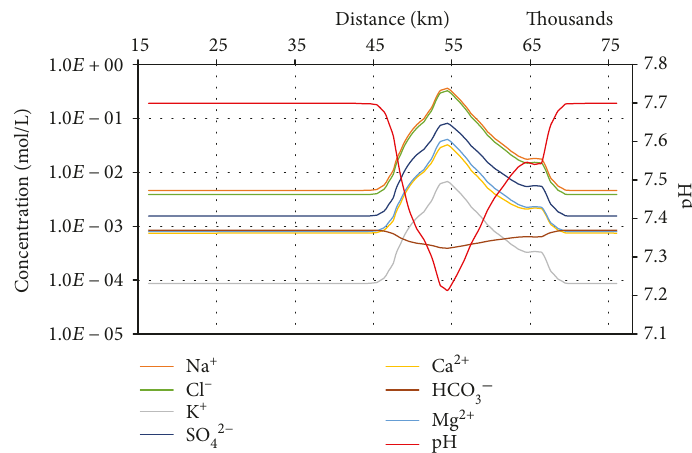
Figure 10: Concentrations (units in moles/L, except for pH) of primary components in the upper 100 m of the